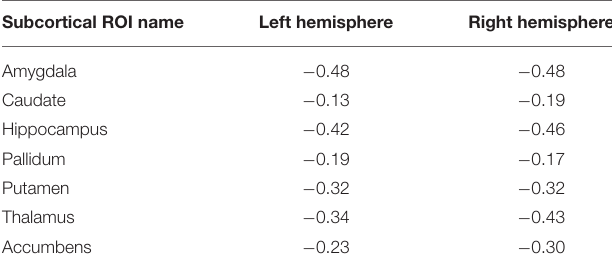
TABLE 3 | Pearson’s correlation coefficient ( r ) for different subcortical ROIs from the Harvard-Oxford atlas between ROI-level brain tissue volume and ROI-level brain-PAD.